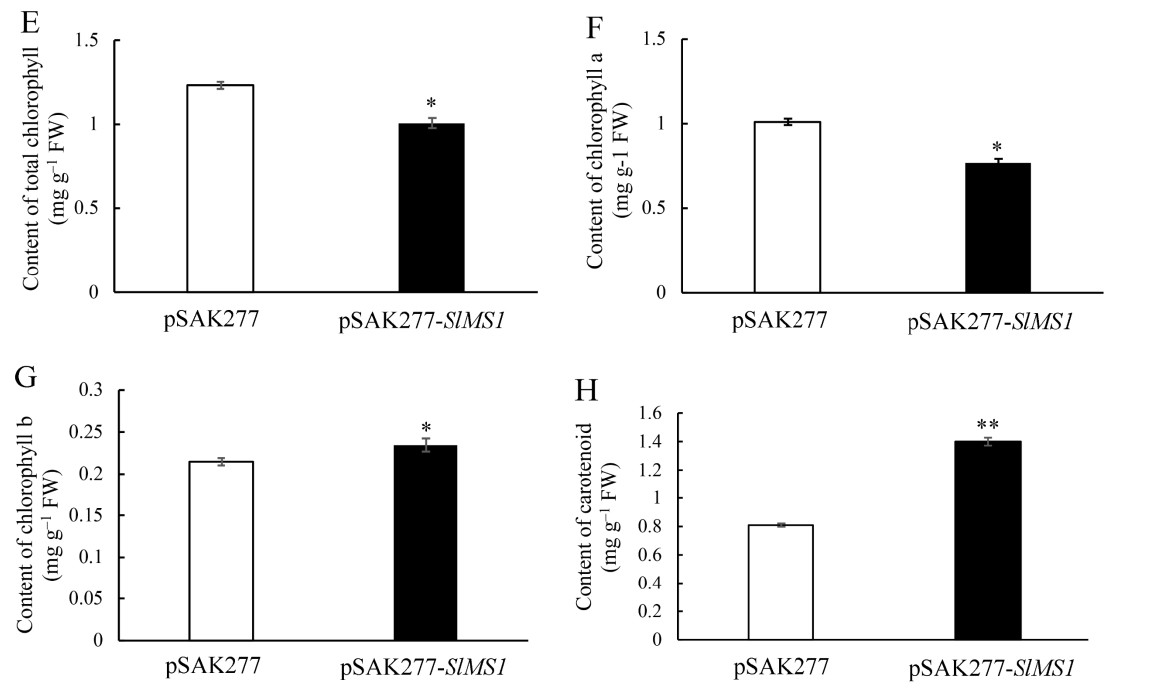
Figure 4. Effect of transient silencing and transient overexpression of SlMS1 on pigment content in tomato fruit. ( A – D ) Content of total chlorophyll ( A ), chlorophyll a ( B ), chlorophyll b ( C ), carotenoids ( D ) in control (TRV) and SlMS1 -silenced fruit (TRV- SlMS1 ) at 21 and 27 days post inoculation. ( E – H ) Content of total chlorophyll ( E ), chlorophyll a ( F ), chlorophyll b ( G ), carotenoids ( H ) in control (pSAK277) and SlMS1 -overexpressed (pSAK277- SlMS1 ) fruit at 10 days post inoculation. The symbols * and ** stand for p < 0.05 and p < 0.01, as determined by Student’s t -test, respectively.